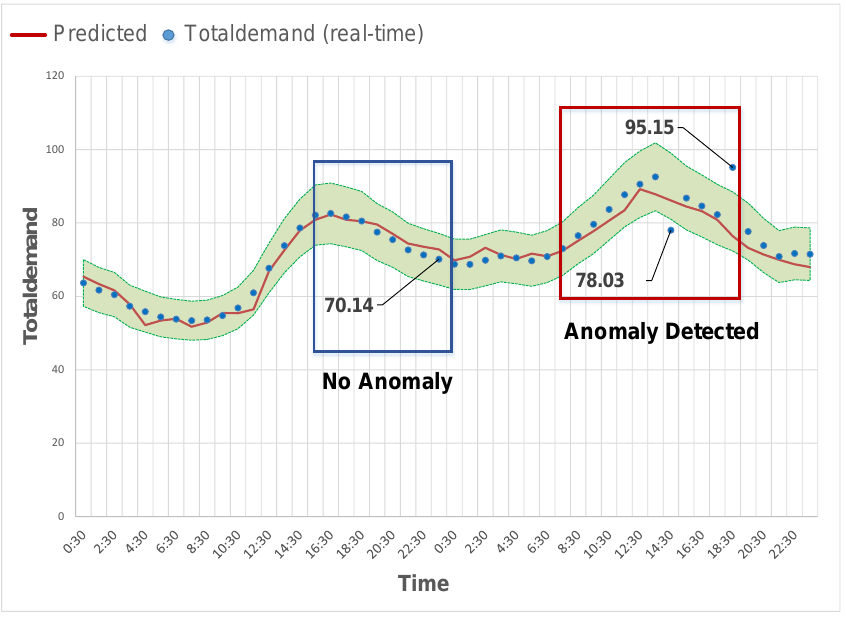
Figure 4. Real-time anomaly detection of whole time period ‘t’.